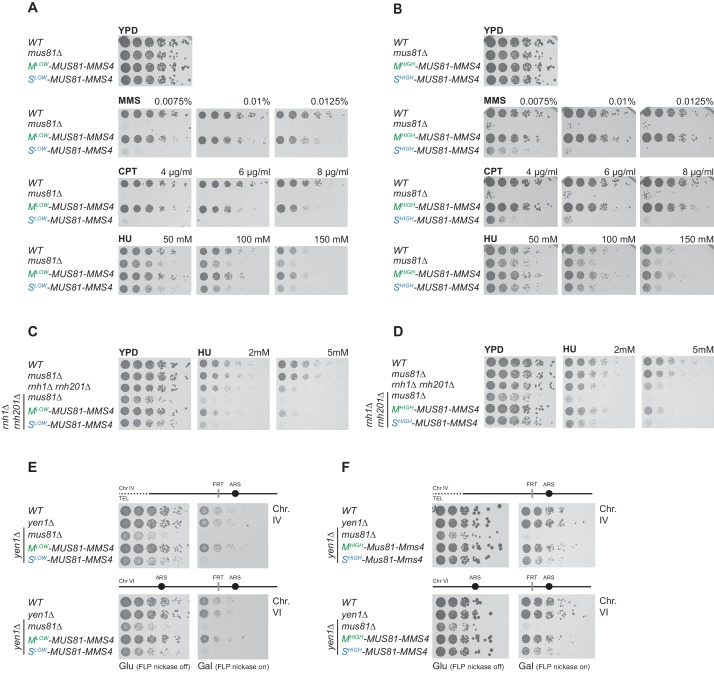
Mus81-Mms4 restricted to M phase, but not S phase is sufficient for the response to genotoxic insults.(A/B) M phase-restricted Mus81-Mms4 is sufficient to confer viability to replication fork stalling drugs. Viability of cells with Mlow (Clb2pClb1 -150bp)-Mus81-Mms4/Slow (Clb6pClb6 -80bp)-Mus81-Mms4 constructs at low peak expression levels (A) or Mhigh (Clb2pClb1)-Mus81-Mms4/Shigh (Clb6pClb5)-Mus81-Mms4 constructs at high peak expression levels (B) is compared to that of WT and mus81Δ cells. Strains were plated in 5-fold serial dilutions on YPD plates containing the indicated amounts of MMS, CPT or HU and incubated at 30°C for 2 days. (C/D) Mitotic function of Mus81-Mms4 is sufficient to confer viability upon induction of RNA-DNA-hybrids in the absence of RNAse H enzymes and mild replication stress (HU). Cell cycle-tagged versions of Mus81-Mms4 were integrated in the rnh1∆ rnh201∆ background. Strains were spotted in 5-fold serial dilutions on YPD containing indicated concentrations of HU and incubated at 30°C for 2 days. (C) Spotting containing Mlow-Mus81-Mms4/Slow-Mus81-Mms4 cells. (D) Spotting of Mhigh-Mus81-Mms4/Shigh-Mus81-Mms4 cells. (E/F) Repair of Flp-nickase induced DNA lesions requires the M phase function of Mus81-Mms4. Galactose-induced DNA nicking is presumed to be followed by replication run-off in S phase to form single-ended DSBs and repair by BIR (Nielsen et al., 2009; Mayle et al., 2015). Location of the corresponding FRT sites on chromosome IV and VI are indicated relative to replication origins. Cells were spotted in 5-fold serial dilutions in presence of glucose or galactose (FLP-induction) and incubated at 30°C for 2 days. (E) Spottings of Mlow-Mus81-Mms4/Slow-Mus81-Mms4 cells. (F) Spottings of Mhigh-Mus81-Mms4/Shigh-Mus81-Mms4 cells.